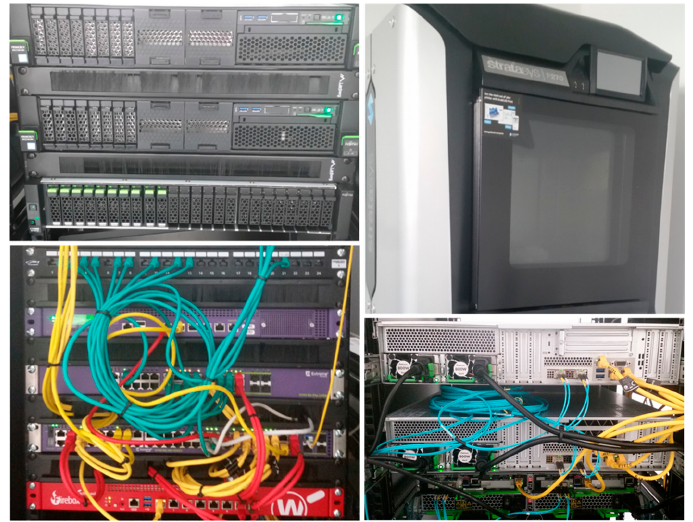
Figure 7. Example elements of the IT and manufacturing infrastructure.